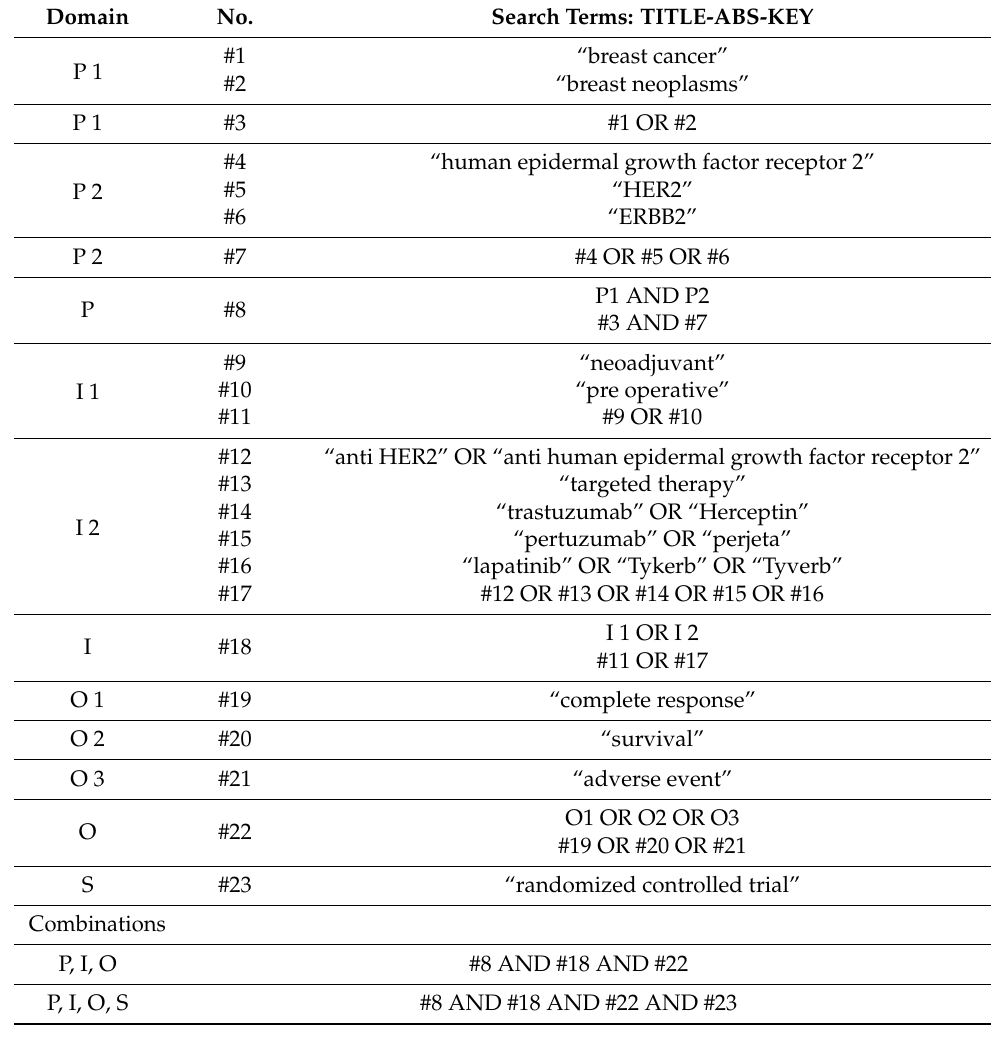
Table A2. Search terms and search strategy in Scopus